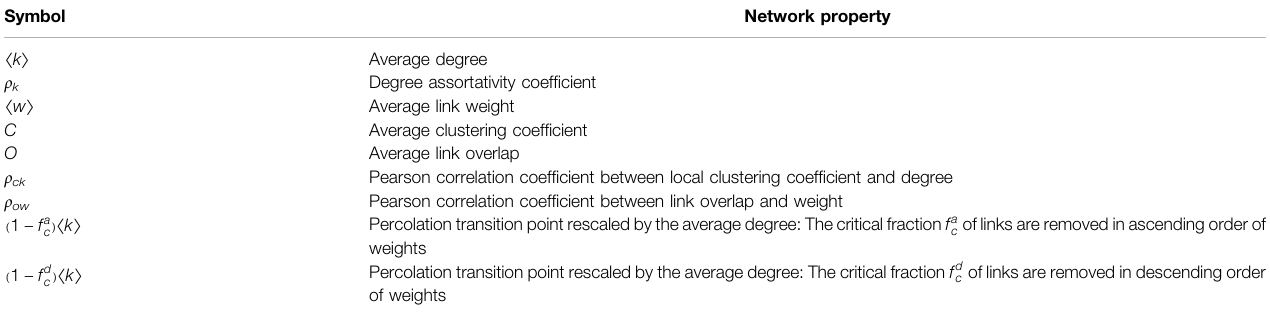
TABLE 2 | Notations of network properties considered in this work. Symbol Network property